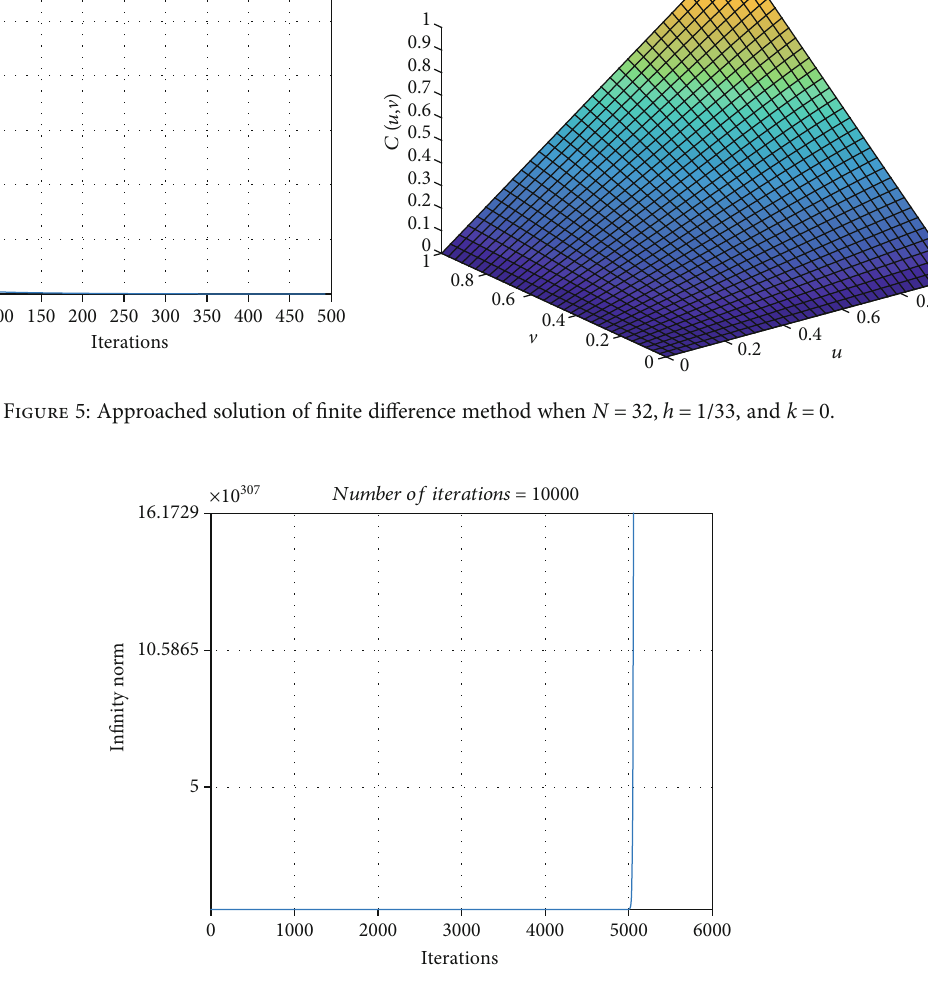
Figure 6: Number of iterations when N = 15, h = 1/16 , and k = 70